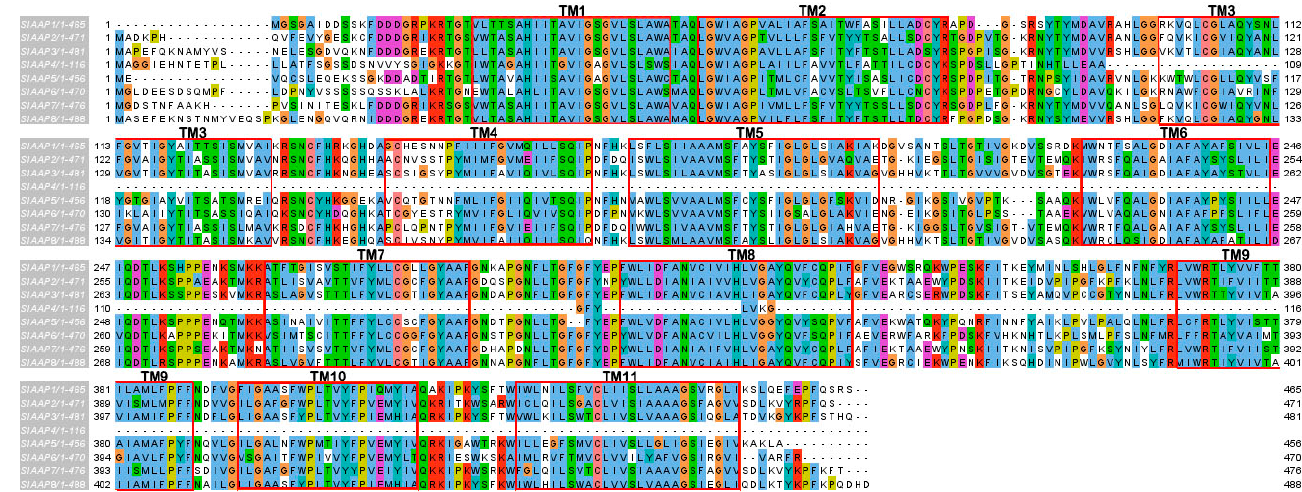
Figure 5. Multiple sequence alignment and TM region of SlAAPs with the default color scheme used for alignments in Clustal X [36]. The TM regions are marked by red. (For interpretation of the references to colors in this figure, the reader is referred to the web version of this article.) TM, transmembrane; AAP, amino acid permease.